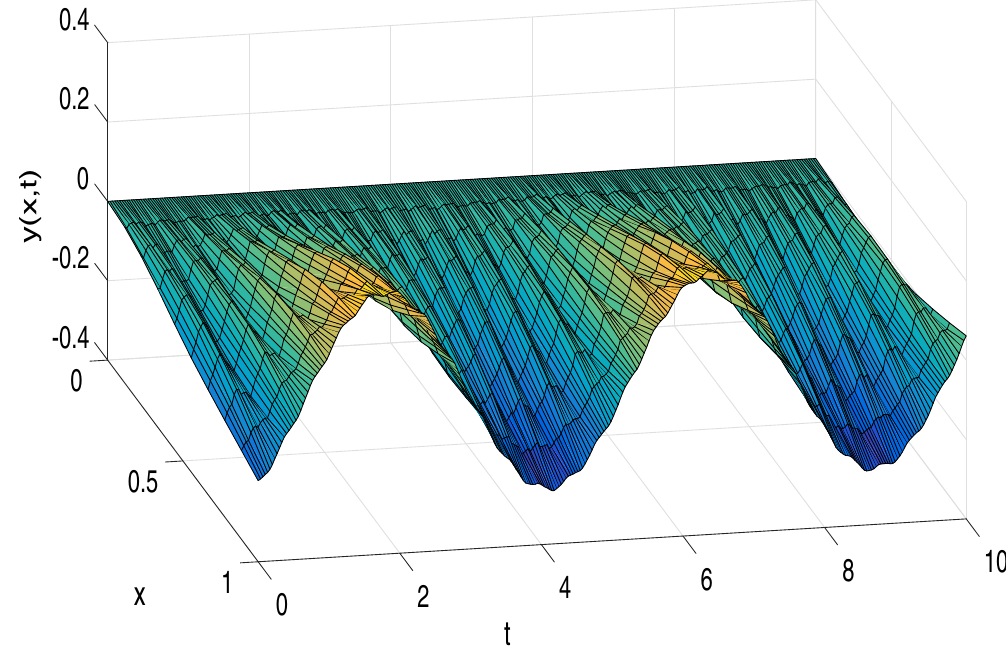
Fig. 2 Displacement y ( x , t ) without